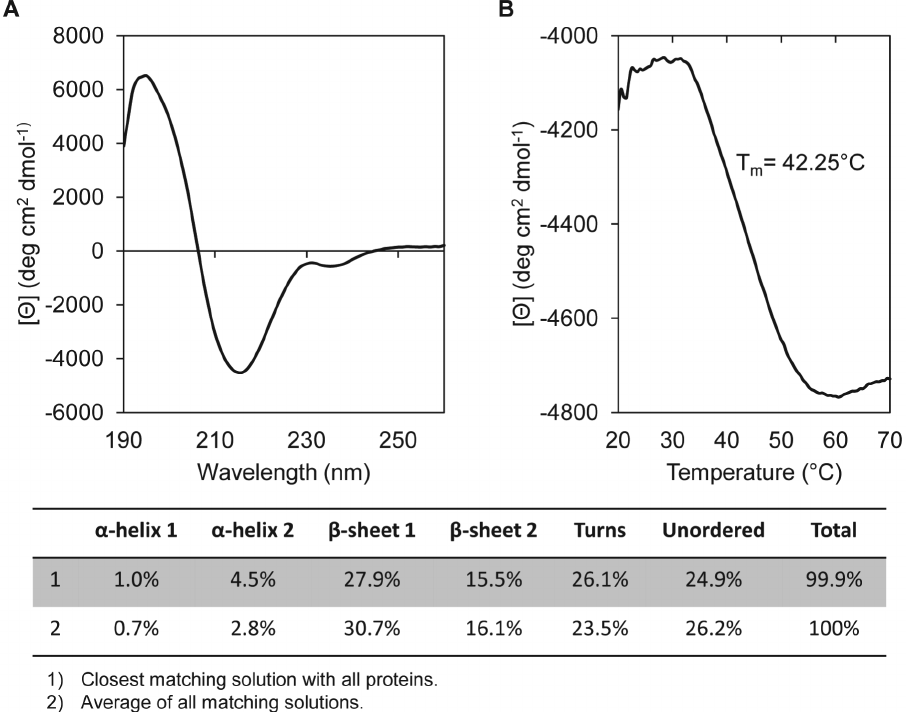
Figure 4. Circular dichroism analysis of stability and structure of AlgMsp. (A) Far-UV CD analysis of AlgMsp structure, representative graph displaying the calculated secondary structure composition. (B) CD-melting curve of AlgMsp. The enzyme was heated at 1 u C/min in 20 mM sodium phosphate buffer pH 8 at a protein concentration of 0.1 mg/ml.